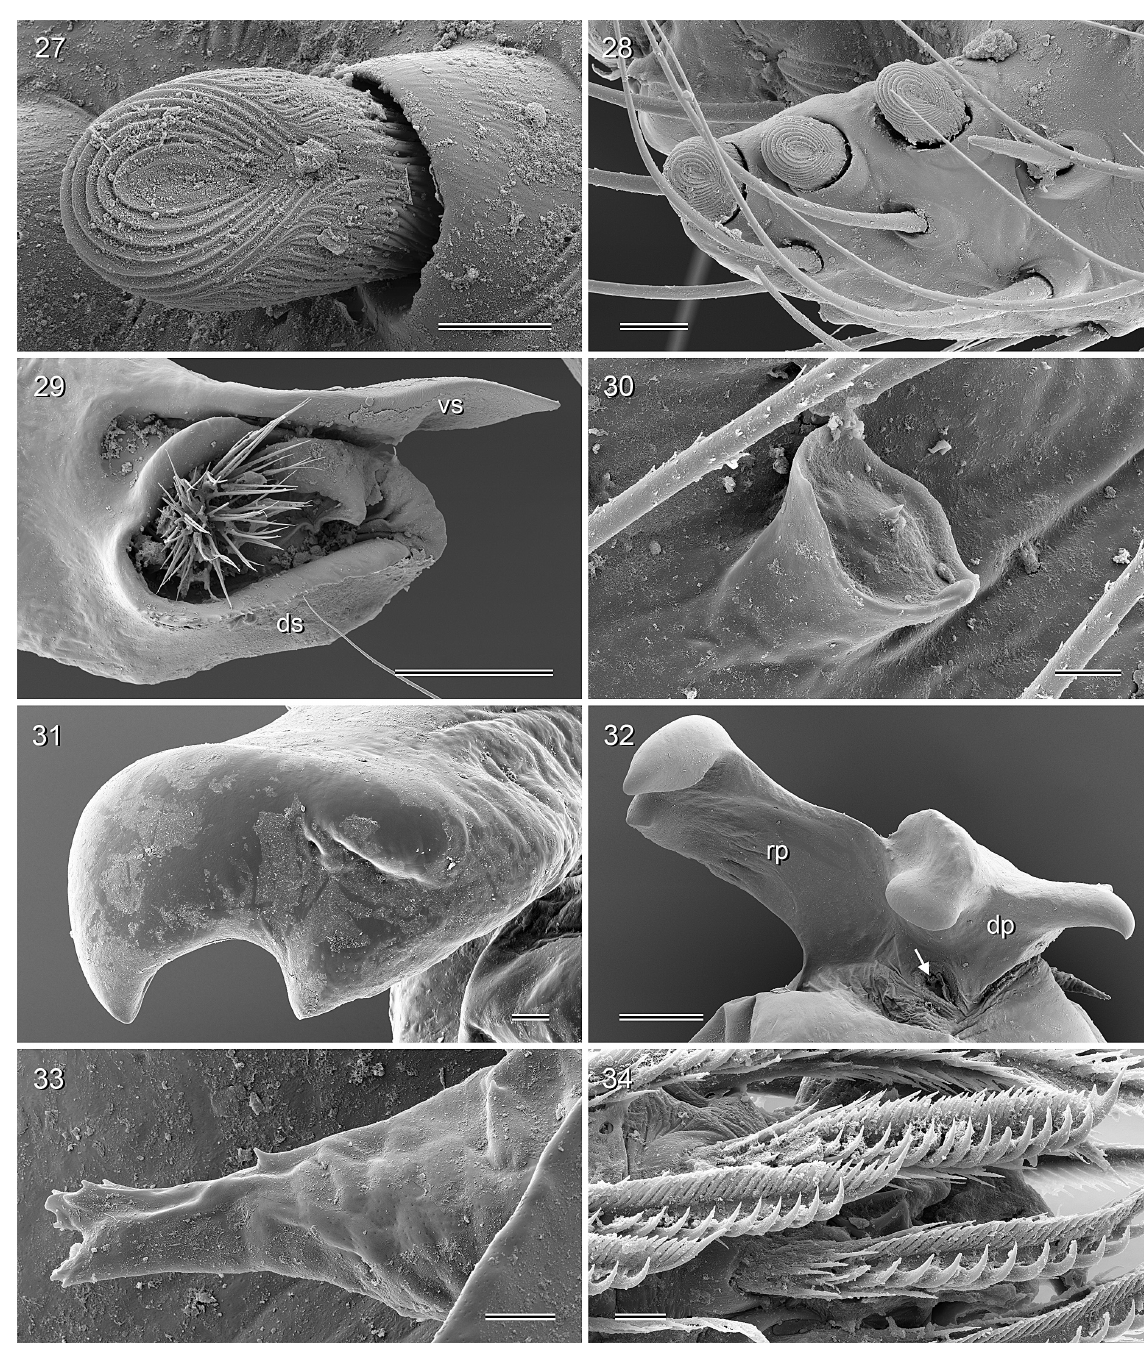
Figs 27–34. Stygopholcus absoloni (Kulczyński, 1914); male from Počitelj/Čapljina, Bosnia and Herzegovina (MHNG). 27 . Modified hair frontally on male chelicerae. 28 . Left male cheliceral apophysis with modified hairs. 29 . Tip of left procursus, retrolateral view. 30 . Male palpal tarsal organ. 31 . Retrolateral bulbal process, distal view. 32 . Bulbal processes; arrow points at opening of sperm duct. 33 . Transparent bulbal process. 34 . Comb hairs on left tarsus 4, prolateral view. Abbreviations: dp = dorsal process; ds = dorsal sclerite; rp = retrolateral process; vs = ventral sclerite. Scale bars: 27, 30, 33, 34 = 10 µm; 28, 31 = 20 µm; 29, 32 = 100